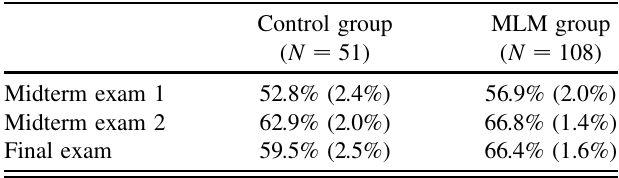
TABLE II. The average exam scores for MLM and control groups with standard errors in parentheses.